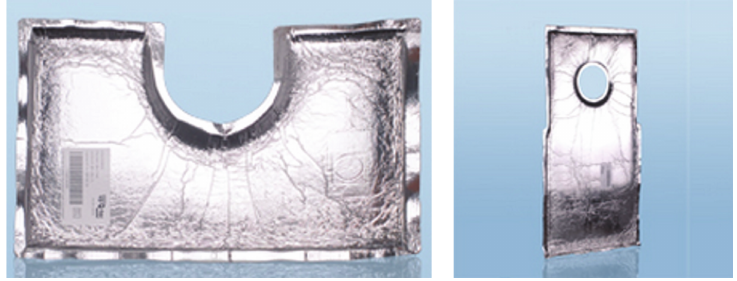
Figure 18: VIP with holes or